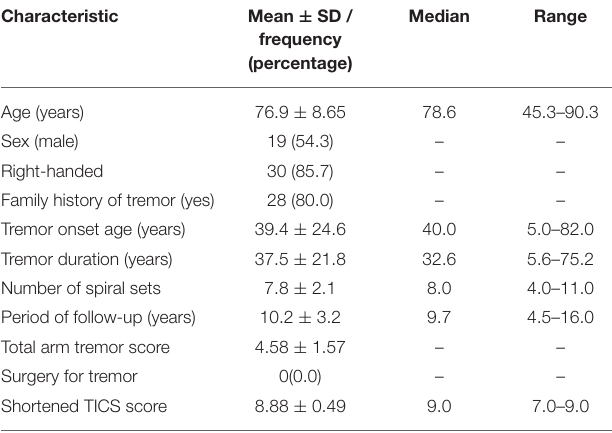
TABLE 1 | Baseline characteristics of ET cases ( n =